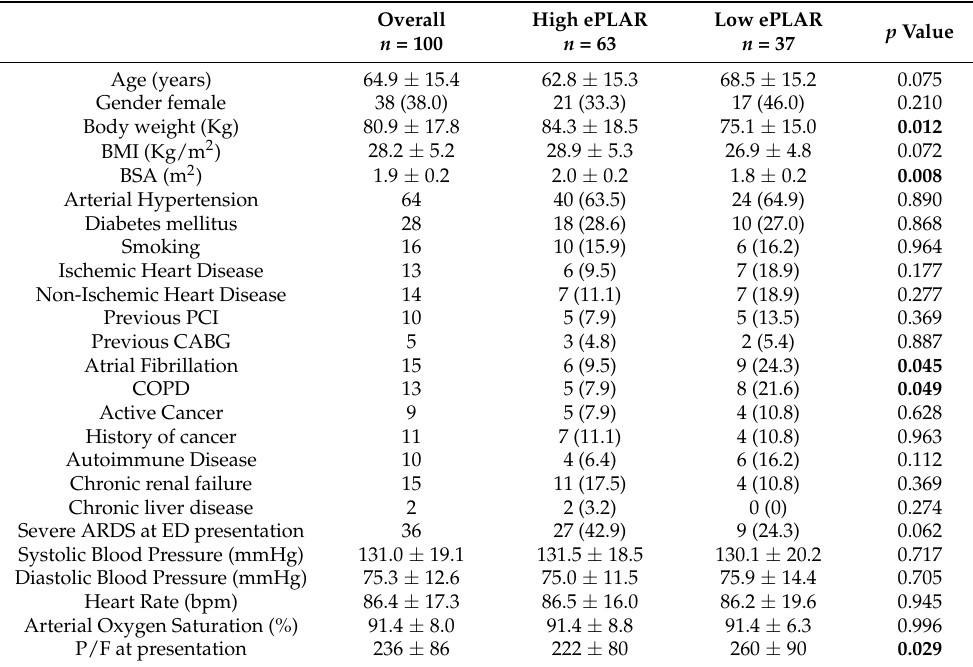
Table 1. Demographic/clinical characteristics of patients with COVID-19, in the overall population and according to ePLAR values at